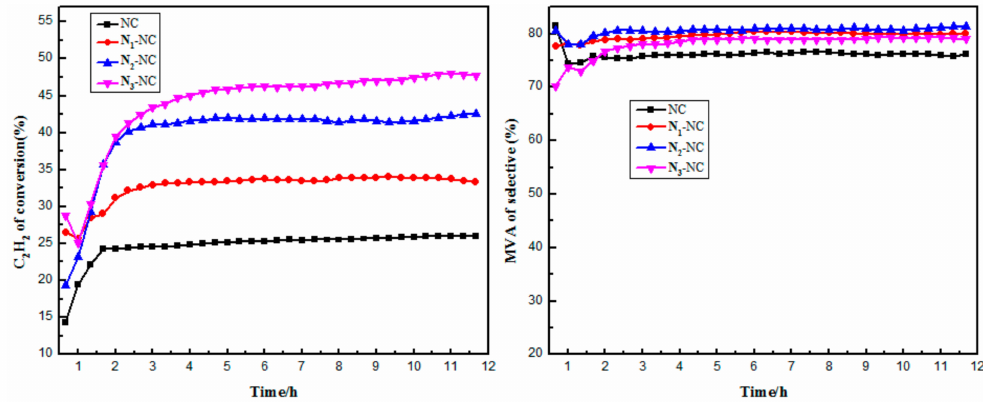
Figure 1. Catalytic performances testing for NC and N -NC in C 2 H 2 dimerization